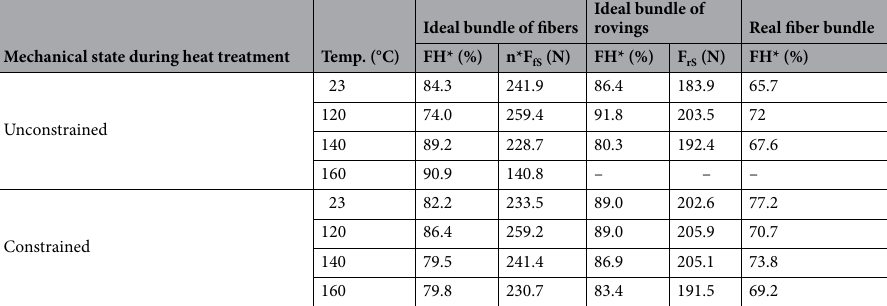
Mechanical state during heat treatment Table 2. Strength utilization data for ideal fiber and roving bundle and its estimation for real fiber bundle.